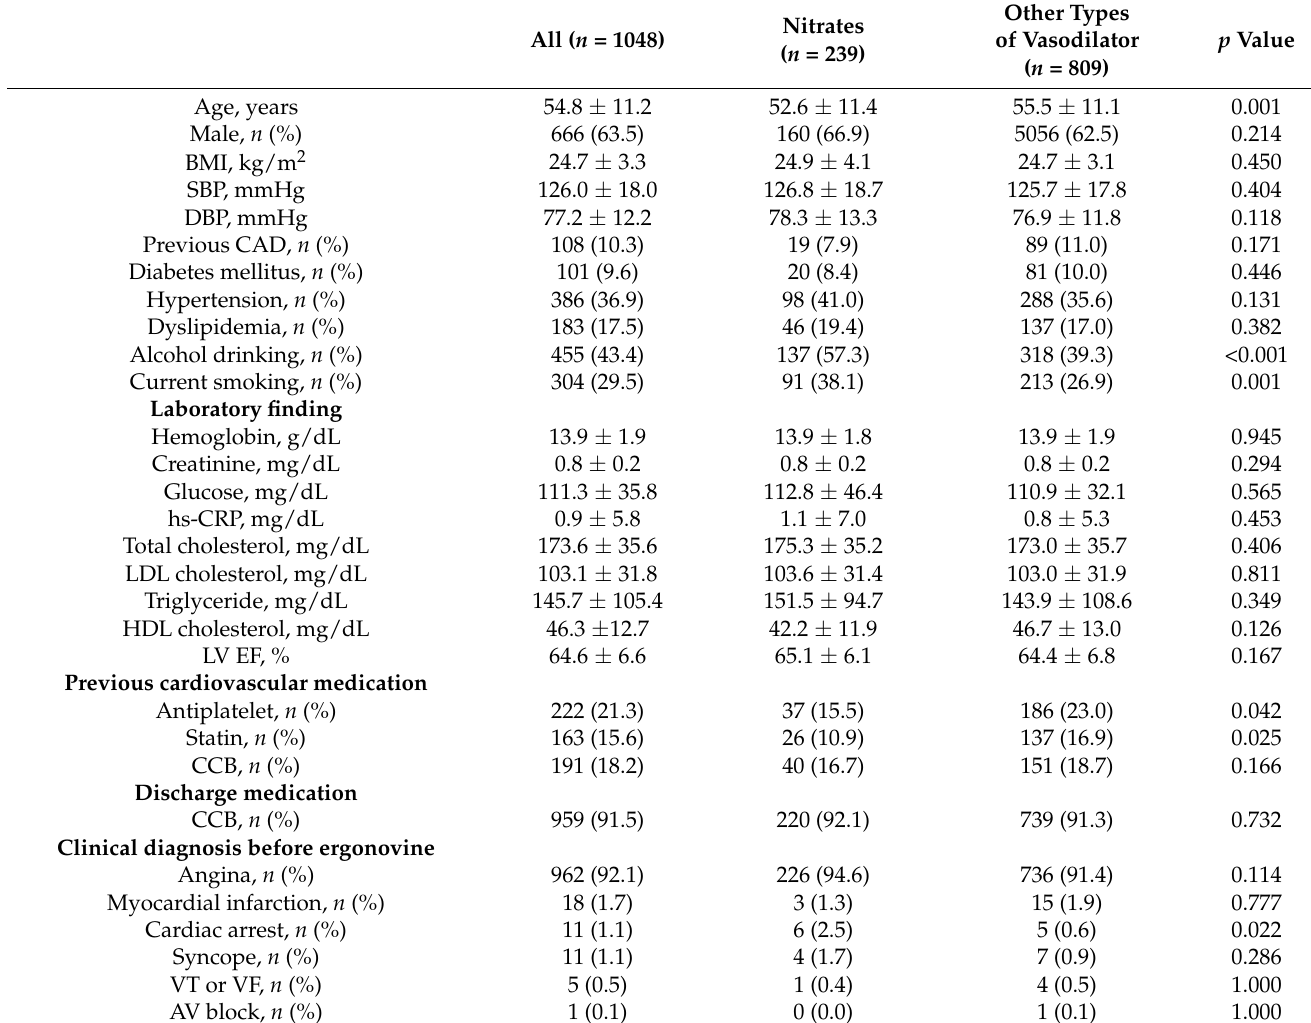
Table 1. Baseline